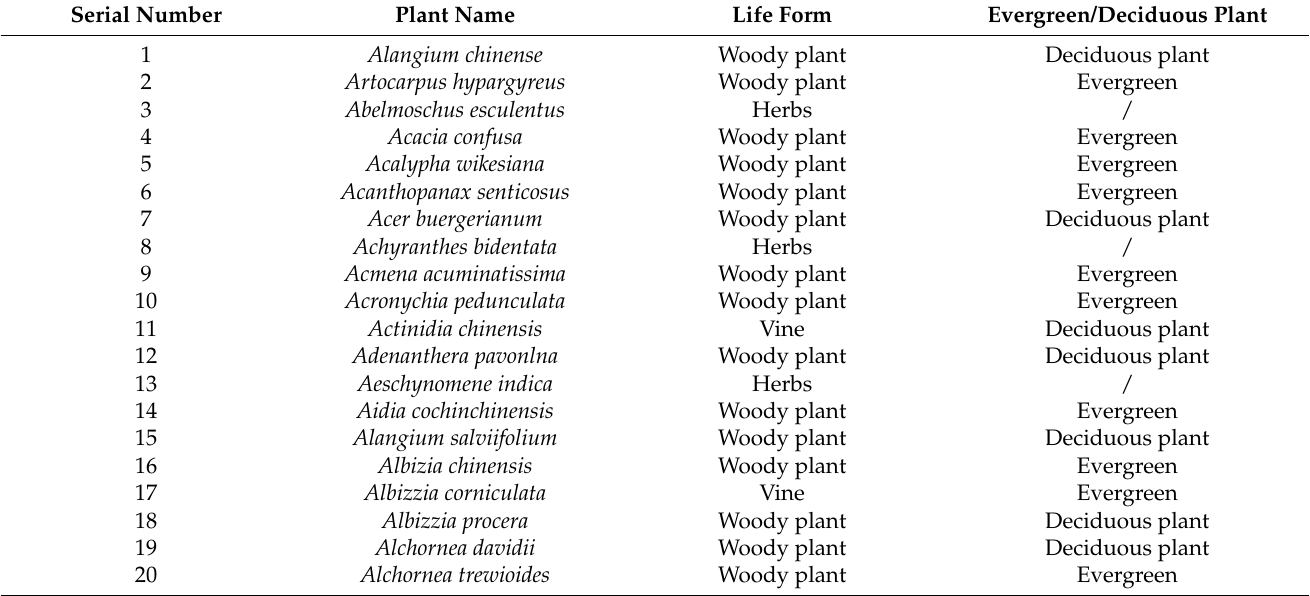
Table A1. Plant species